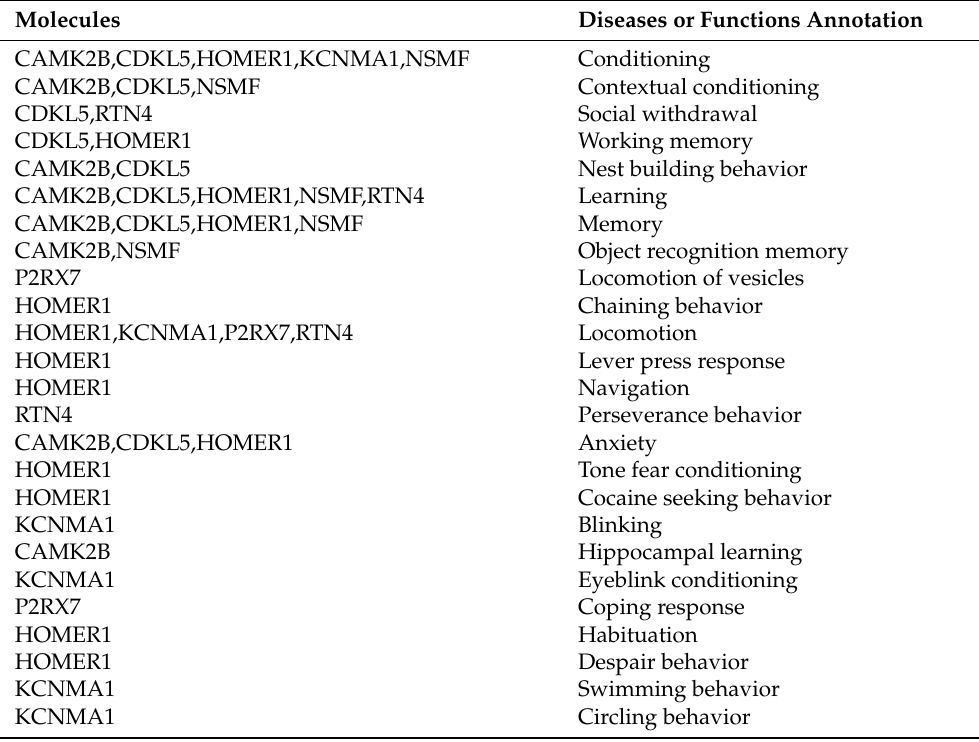
Table 2. Propofol-induced dysregulated synaptic genes associated with cognition and behavior.